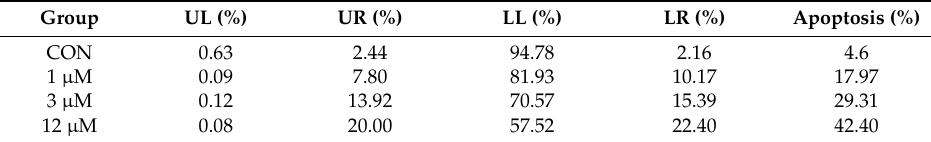
Figure 6. Different concentration of compound 4 of ( a ) compared group, ( b ) 1 µ M, ( c ) 3 µ M and ( d ) 12 µ M on the HepG2 cell apoptosis rate. x -axis: Annexin V FITC; y -axis: PI. Table 5. Compound 4 on the HepG2 cells’ apoptosis